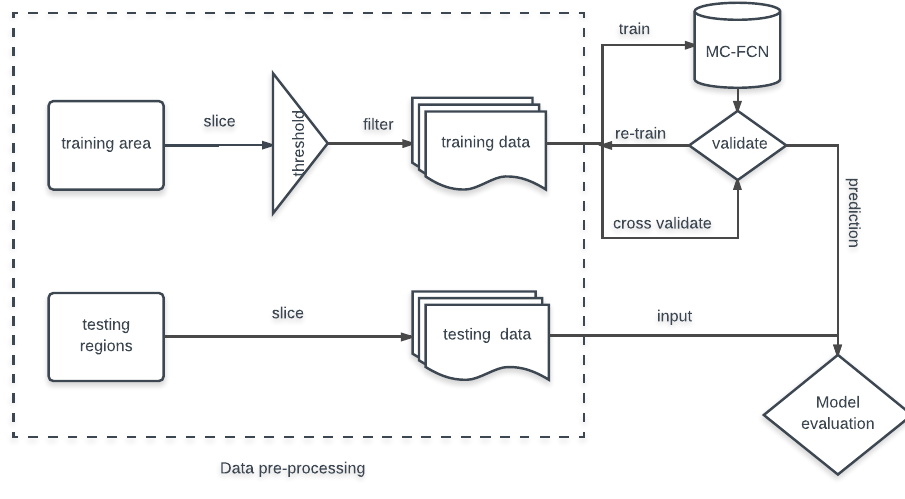
Figure 2. Scheme of the experiment. The MC–FCNs are trained and cross-validated using training dataset, then evaluated by the testing